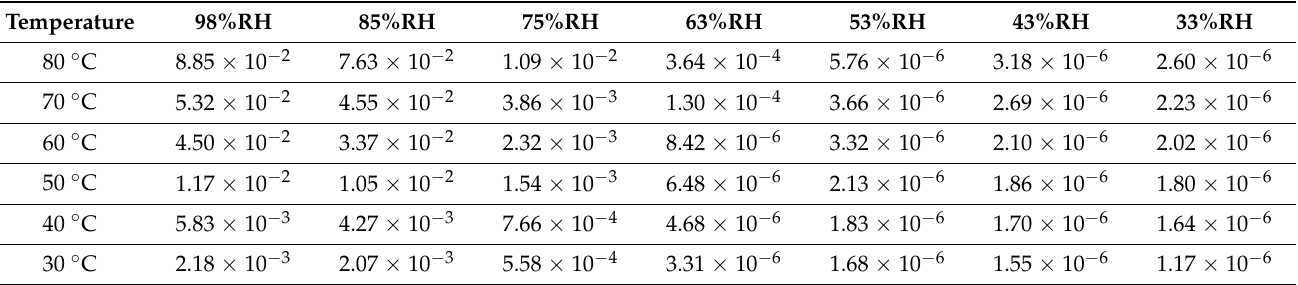
Table 1. Temperature-dependent proton conductivities (S · cm − 1 ) of the synthesized PA-PhSO 3 H under different relative humidity conditions.